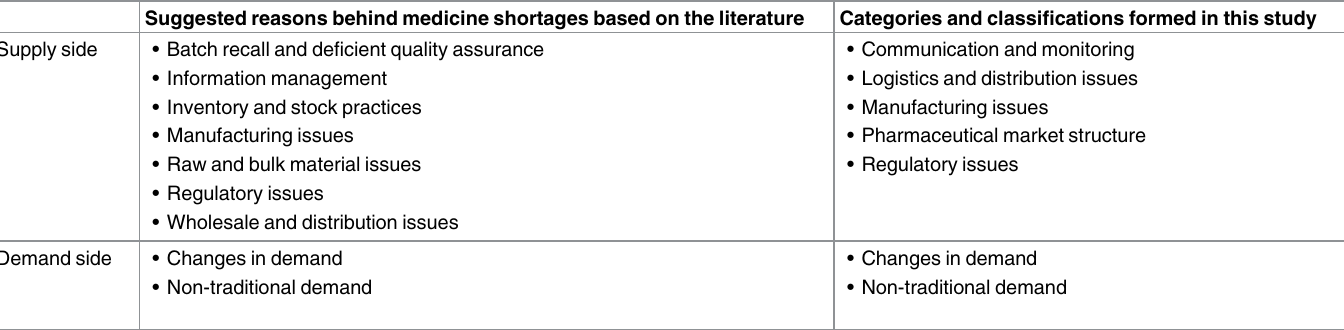
Table 2. Suggested reasons behind medicine shortages based on the literature [4–5]and the categories and classifications formed in this study. Suggested reasons behind medicine shortages based on the literature Categories and classifications formed in this